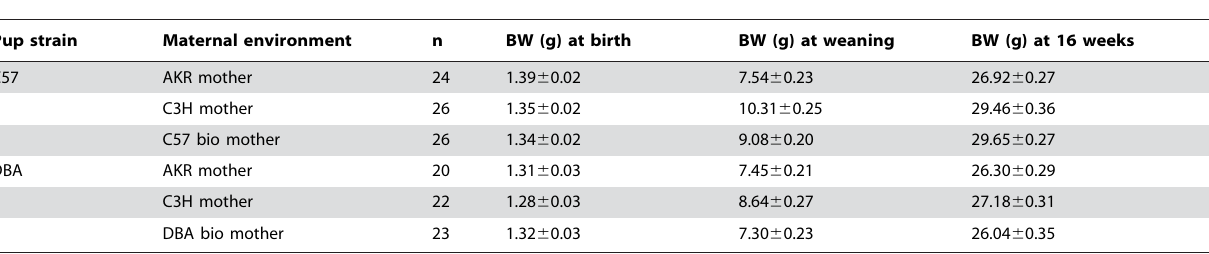
Table 1. The impact of maternal environment on